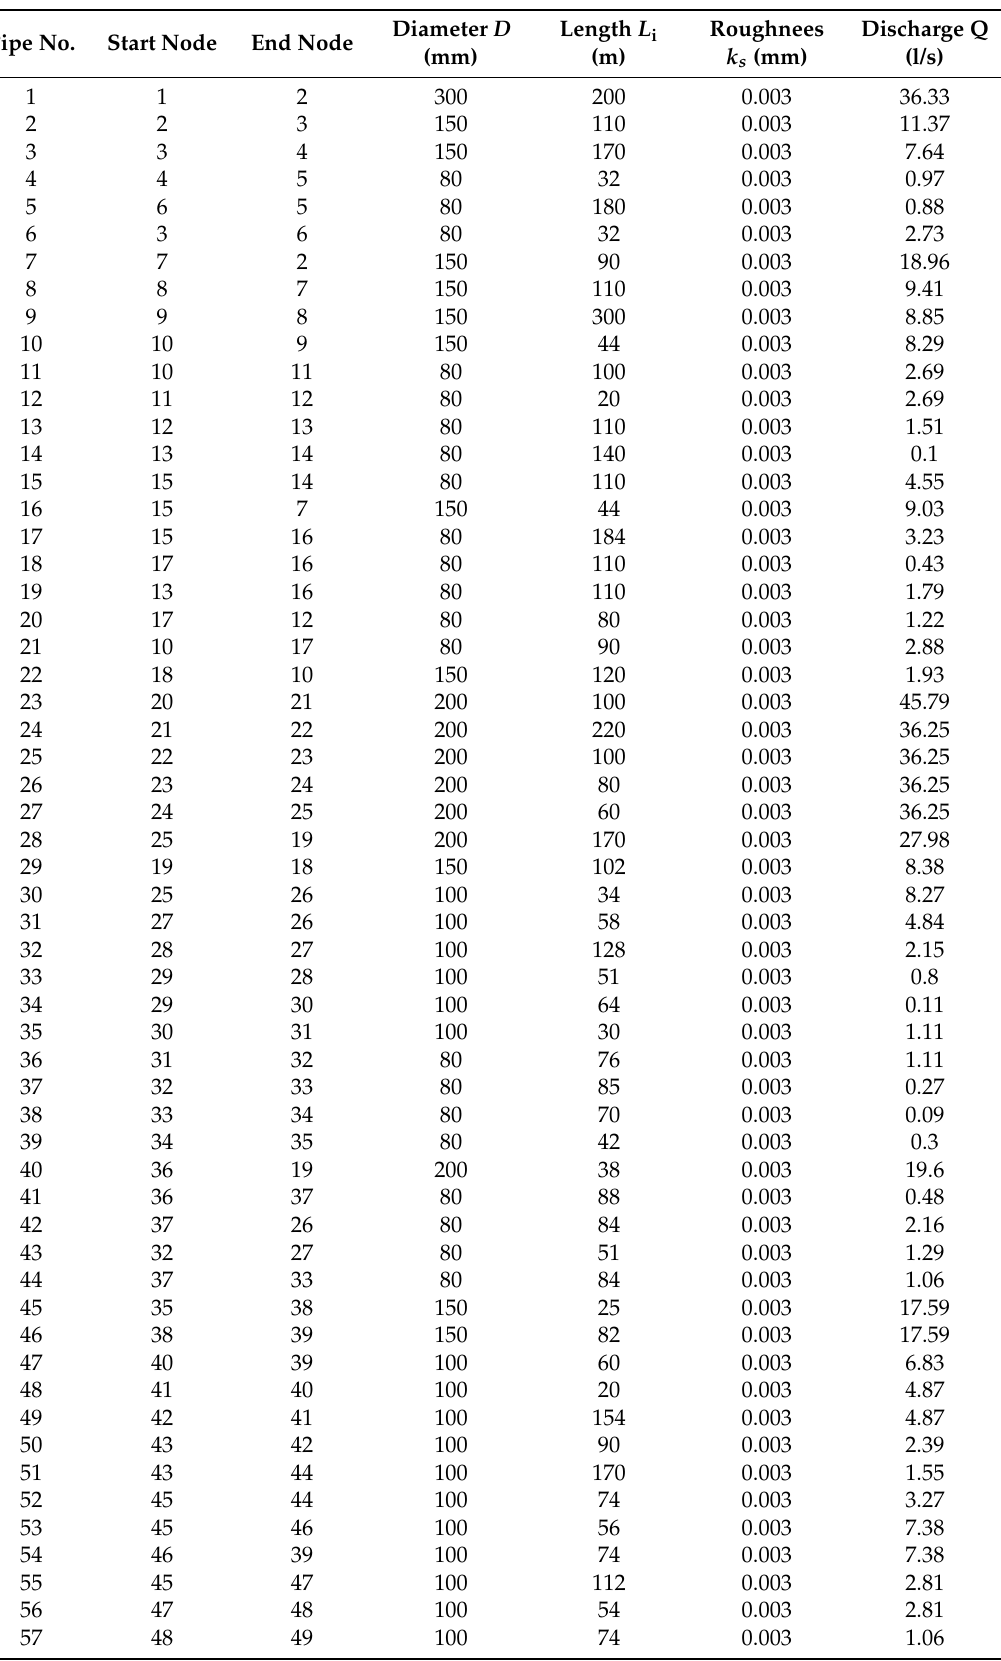
Table A1. Misilmeri network pipe